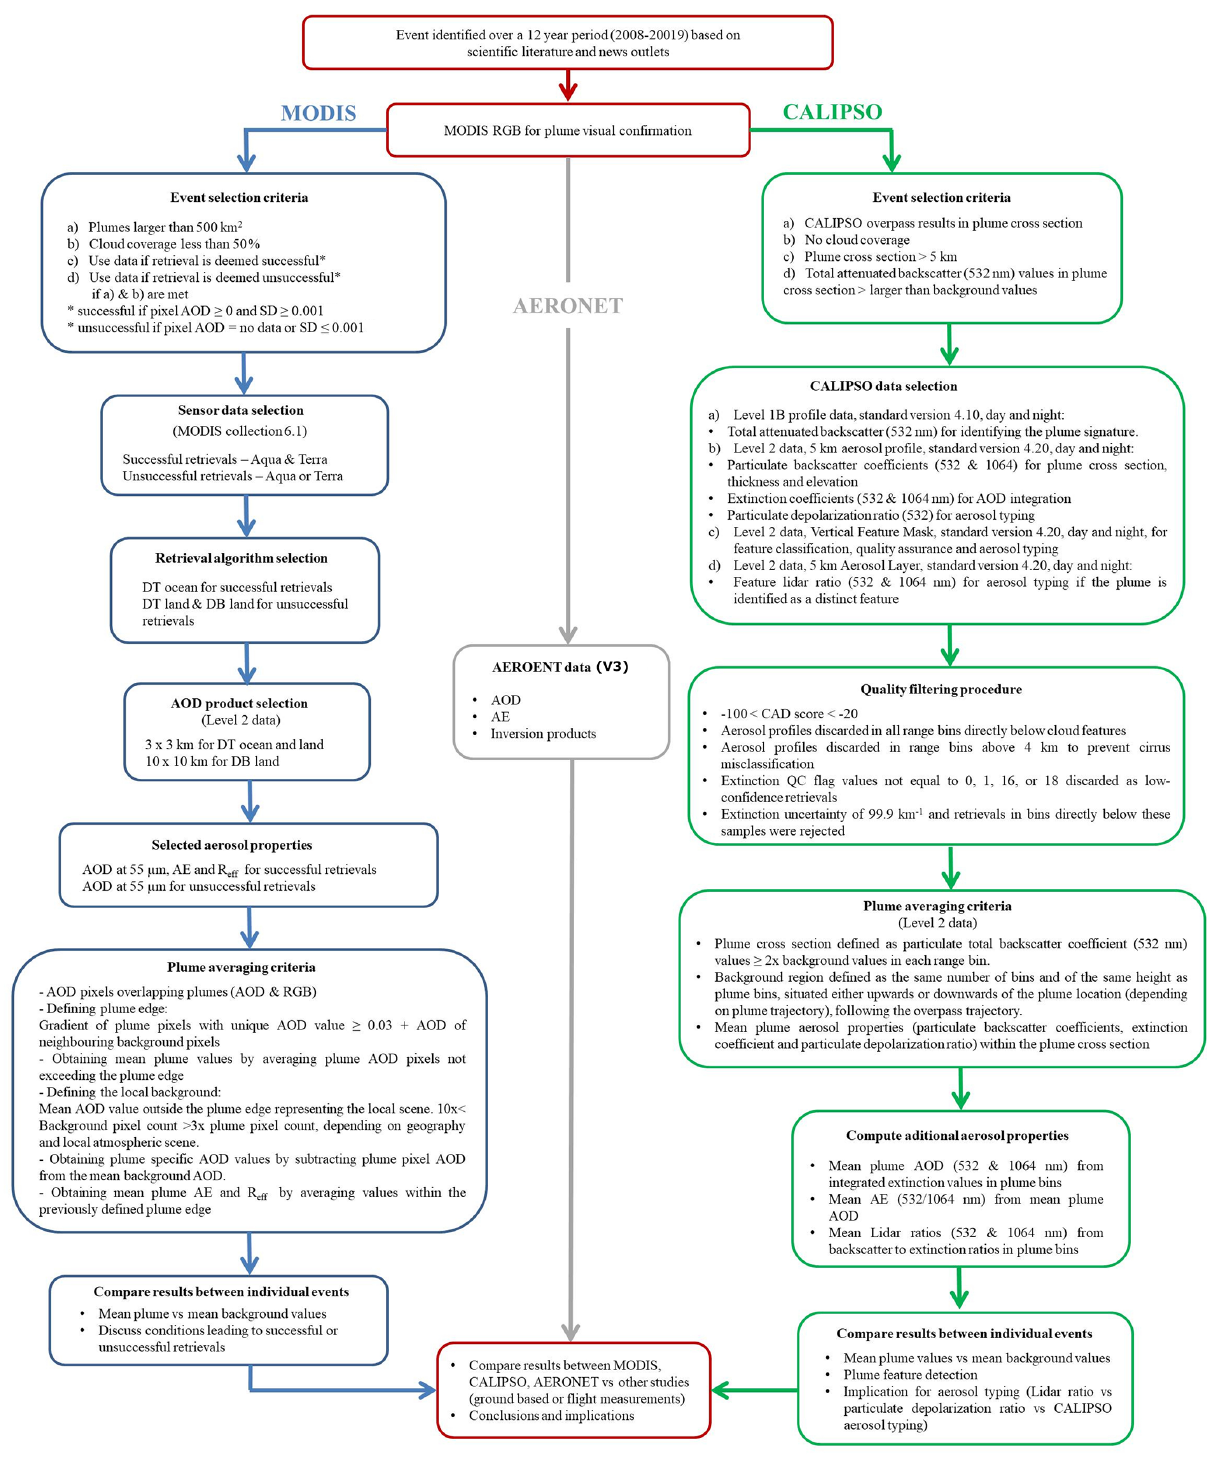
Figure 1. Flowchart of the plume analysis